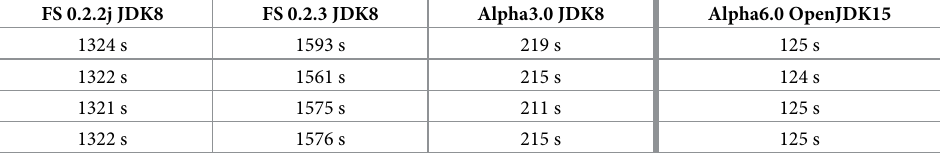
Table 2. Comparison of runtime of different FS versions before and after refactoring. Version 0.2.2j was published by Benjamin Eltzner [22], version 0.2.3 is the first version after start of refactoring process. Version Alpha3.0 is an unpublished developer version with refactoring process completed. Version Alpha6.0 is using OpenJDK15